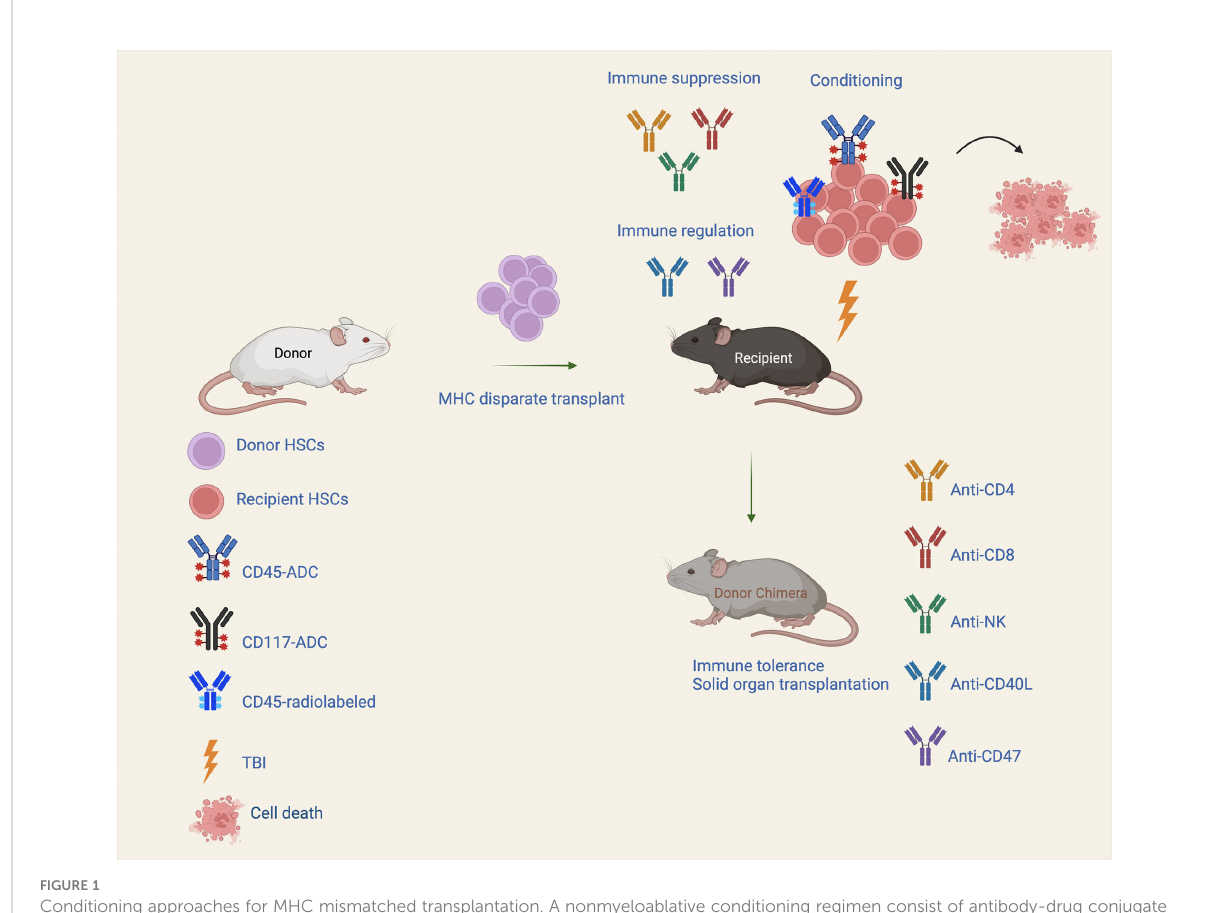
FIGURE 1 Conditioning approaches for MHC mismatched transplantation. A nonmyeloablative conditioning regimen consist of antibody-drug conjugate (ADC) targeting hematopoietic stem cells (HSCs) along with immune suppression and/or transient immune regulation can enable durable alloengraftment in fully MHC-disparate HSCT recipients. Immunotoxins that can ef fi ciently deplete hematopoietic stem and progenitor cells, and/or lymphoid cells may allow robust donor engraftment with great potential to confer the bene fi t of fully myeloablative conditioning but with signi fi cantly reduced